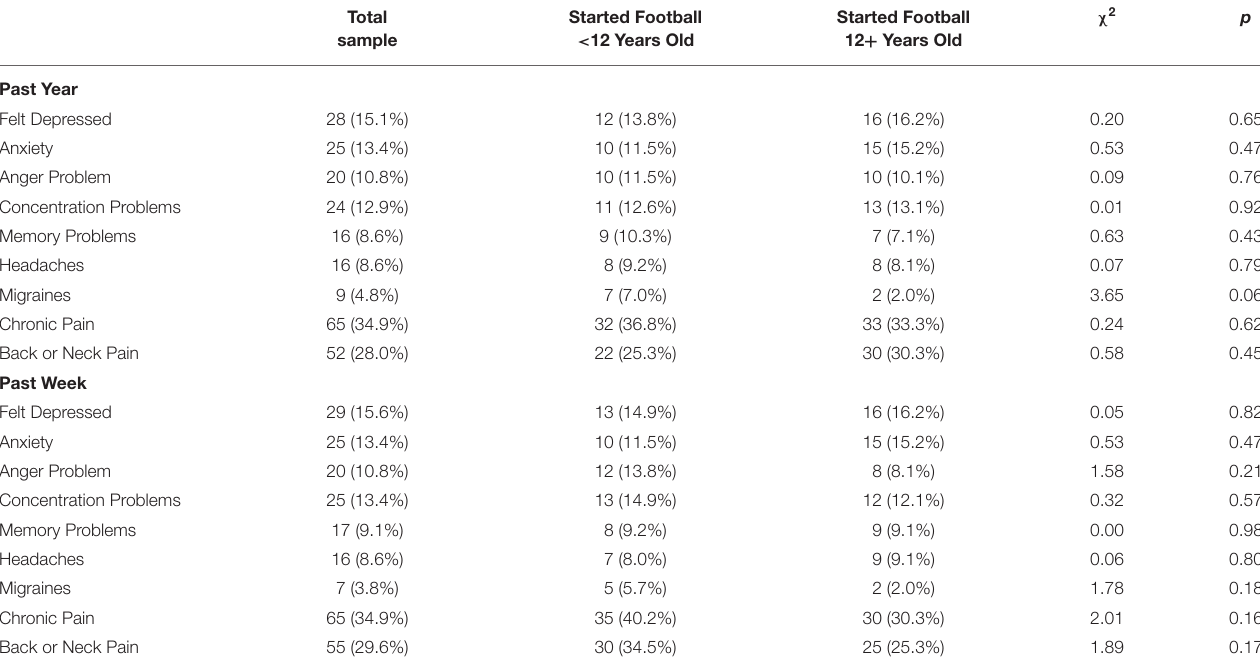
TABLE 3 | Mental health, cognitive, and chronic pain problems in the past year and past week.